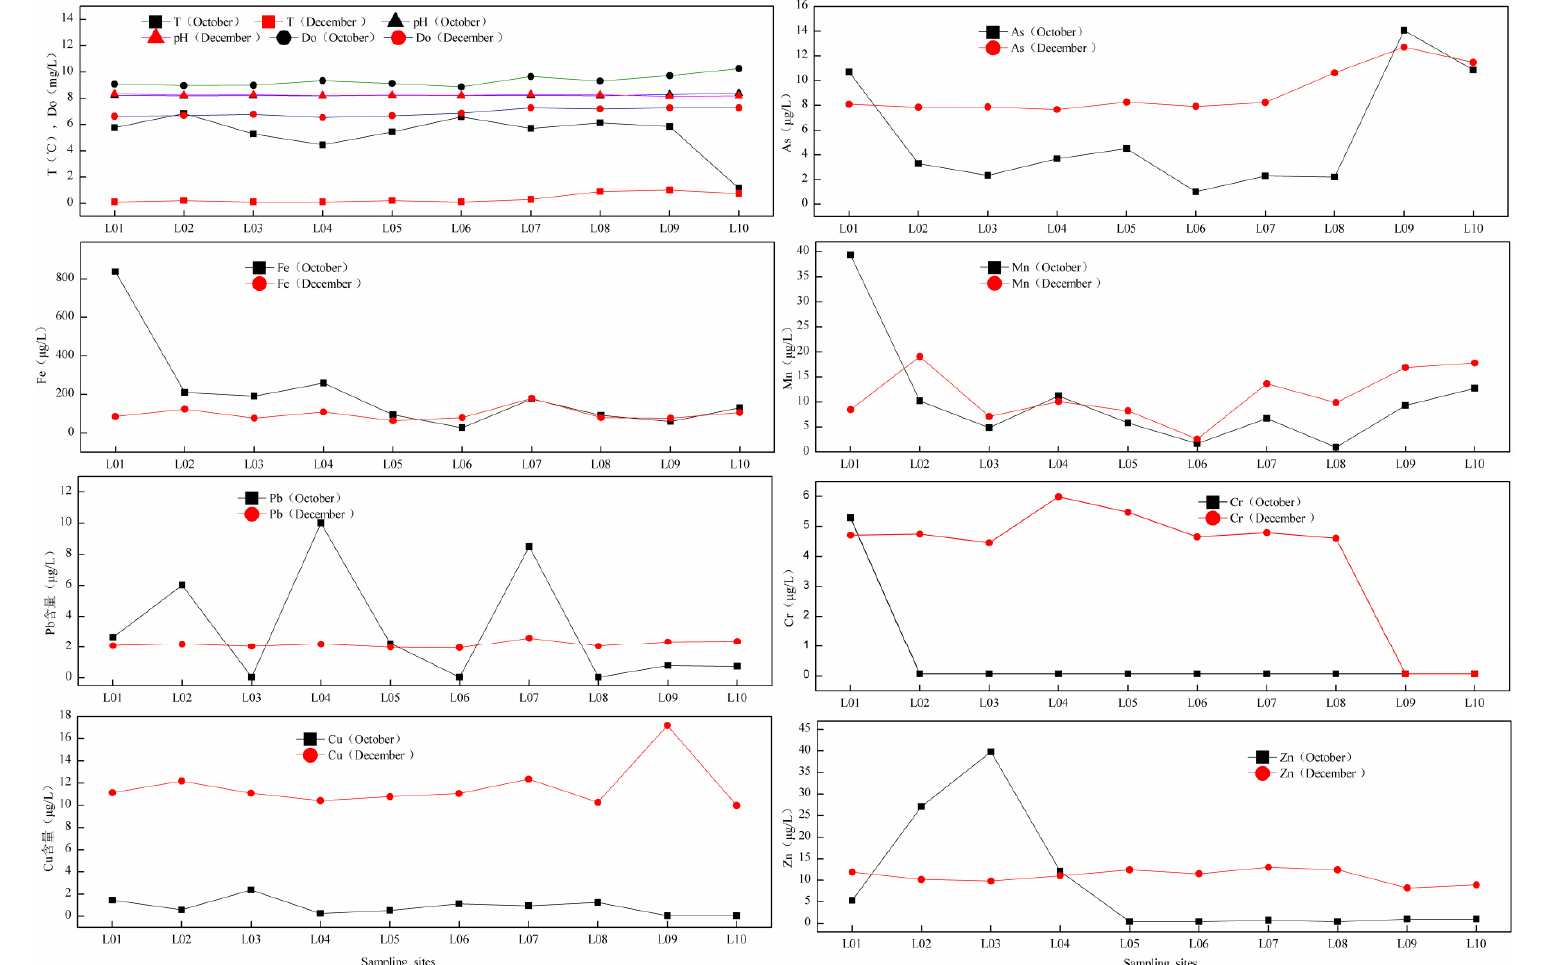
Figure 3. Temporal and spatial distribution of trace elements in upper Lancang River.